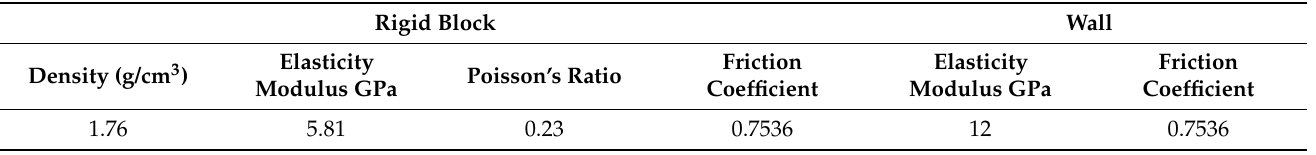
Figure 4. Numerical model of expansion test. Table 2. Numerical model